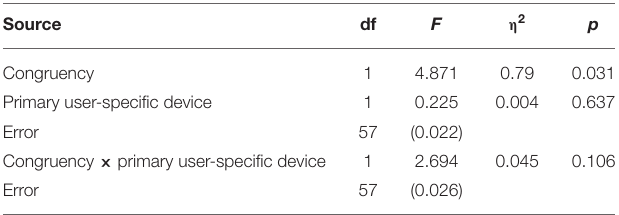
TABLE 4 | A 2 (congruency with others’ perspective: congruent, incongruent) × 2 (primary user-specific device: self-user, other-user) repeated-measures ANOVA in Experiment 2.